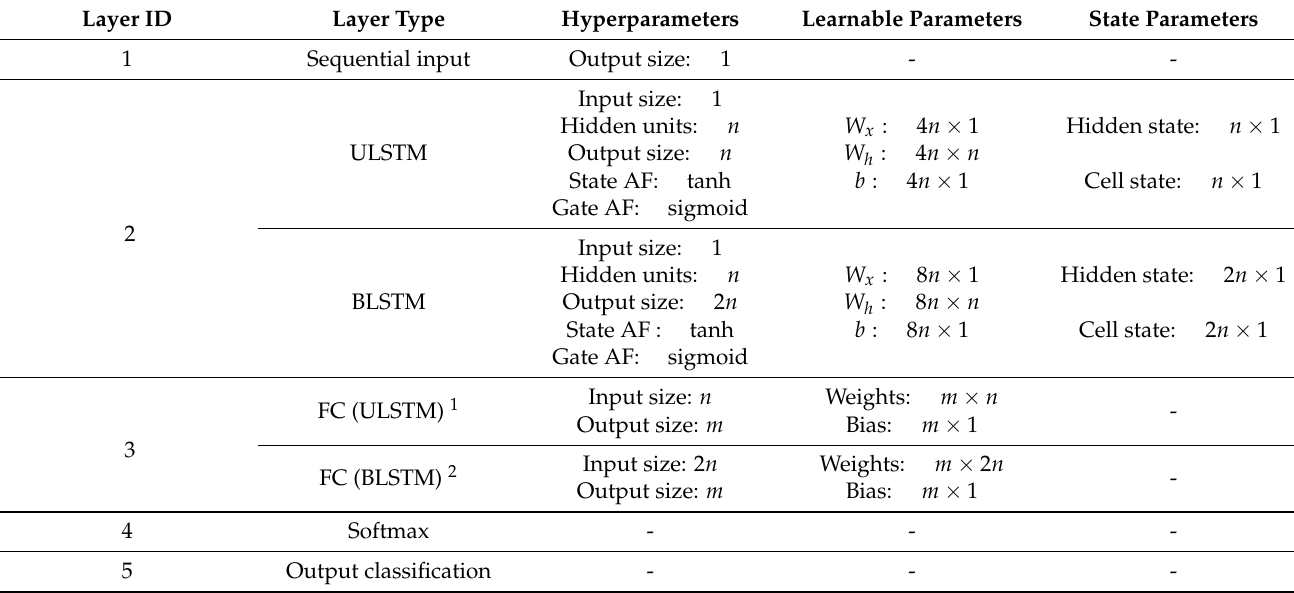
Table 4. Layer description of the LSTM deep learning